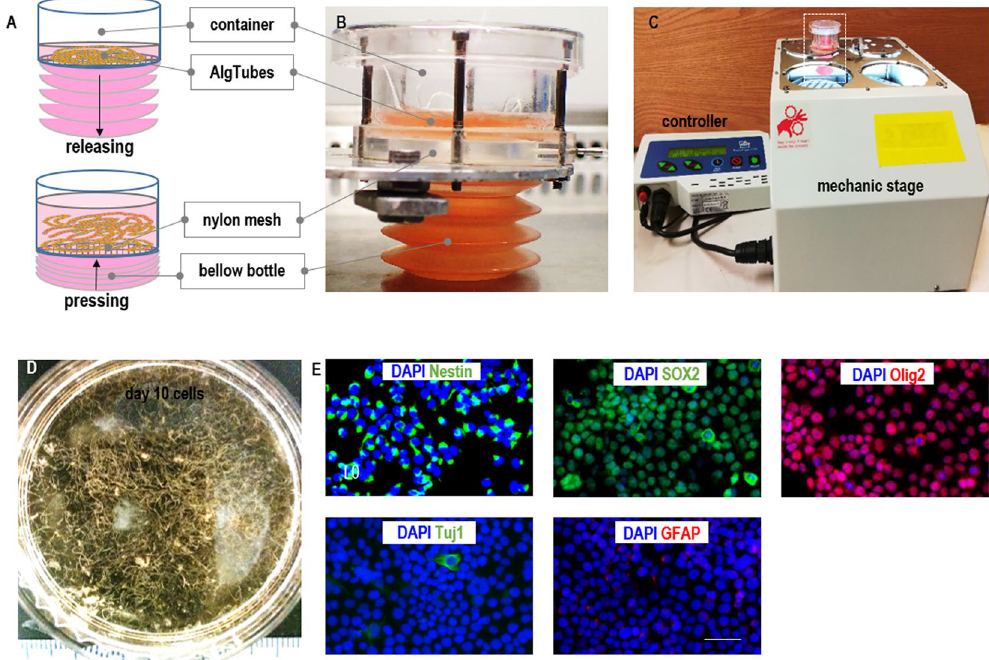
Figure 6. A prototype bioreactor for scalable TICs production. ( A ) The bioreactor contains a cylindrical container and a plastic bellow bottle, which are separated by a nylon mesh. AlgTubes with TICs are suspended in the cylindrical container and the medium is stored in the plastic bellow bottle that can be pressed to flow the medium into, or released to withdraw the medium from the container. ( B , C ) Images of the bioreactor. The mechanic stage is used to press and release the bellow bottle. The controller can be programmed for the pressing and releasing speed, as well as the duration of the interval between the pressing and releasing. ( D ) Glioblastoma TICs harvested from the bioreactor on day 10. TICs grew well and yielded ~3.0 × 10 8 cells/mL. ( E ) Immunostaining of the cultured TICs. Majority of L0 were Nestin + , SOX2 + and Olig2 + . Few L0 cells were Tuj1 + and GFAP + . Scale bar: 50 µ